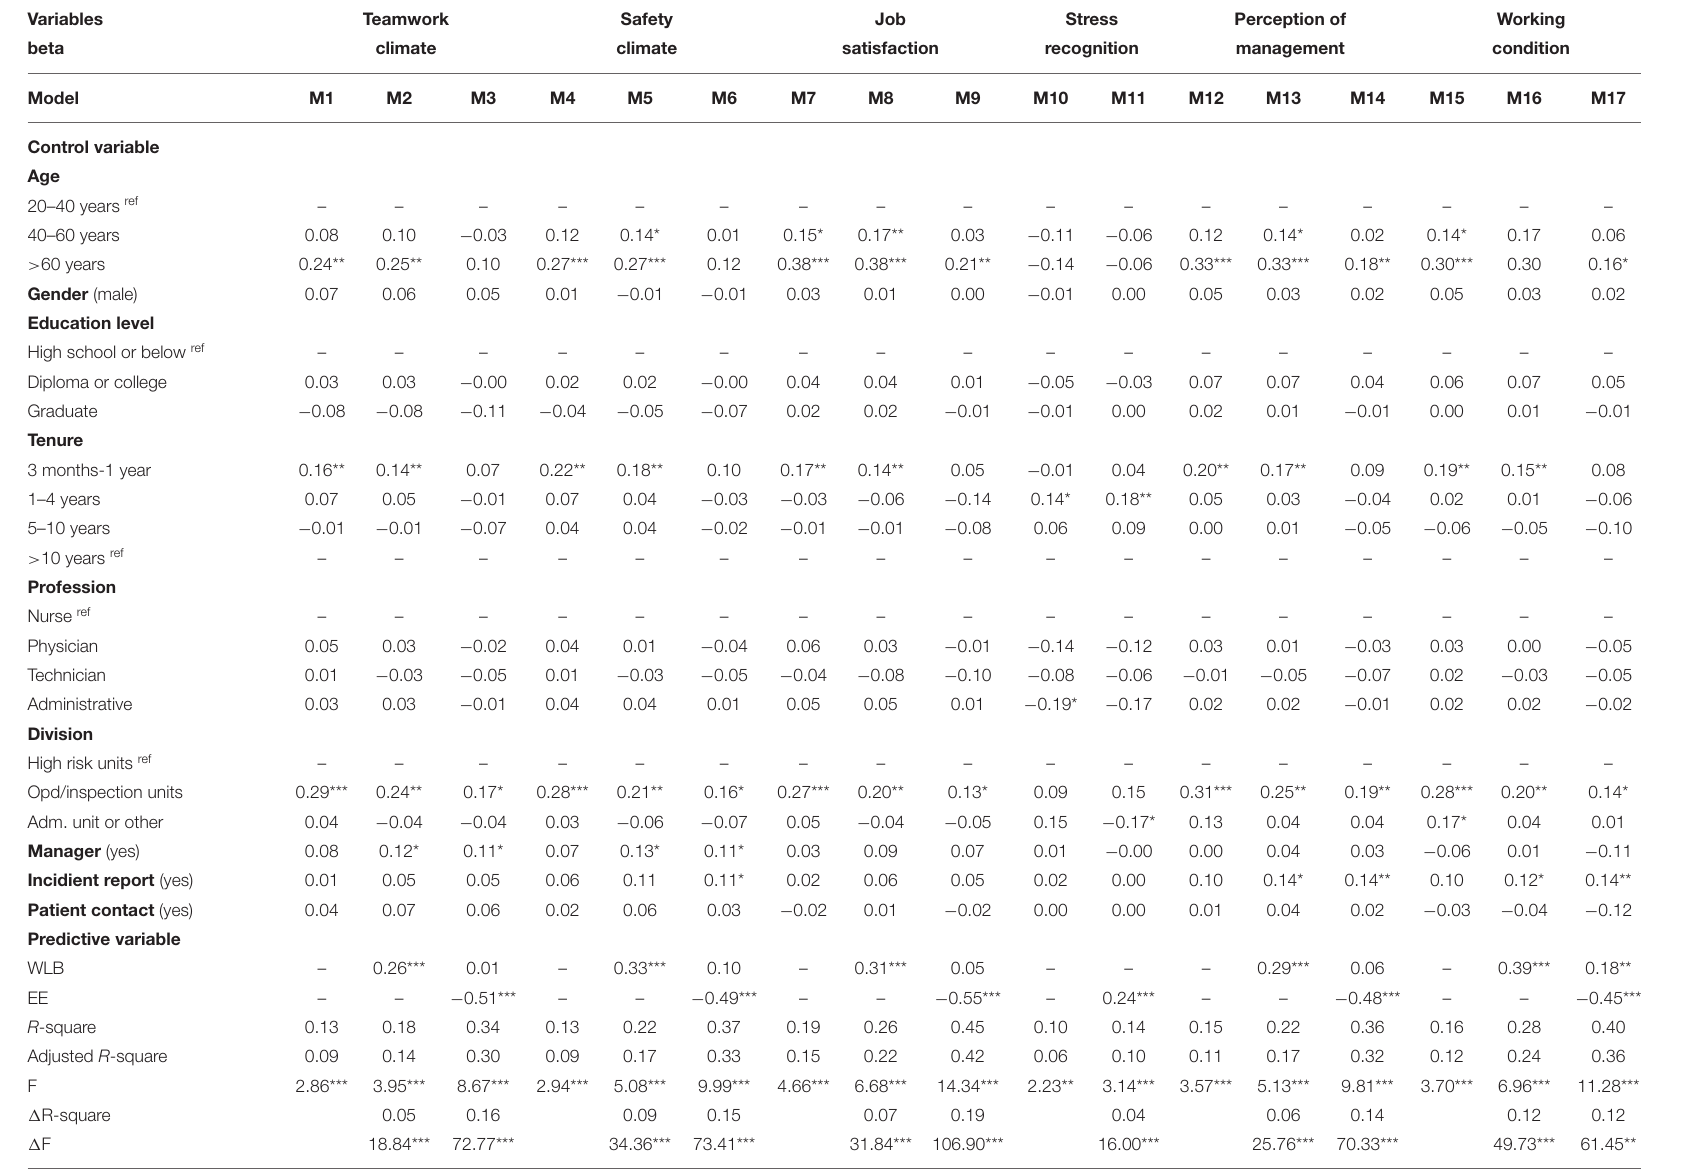
TABLE 6 | Hierarchical models of